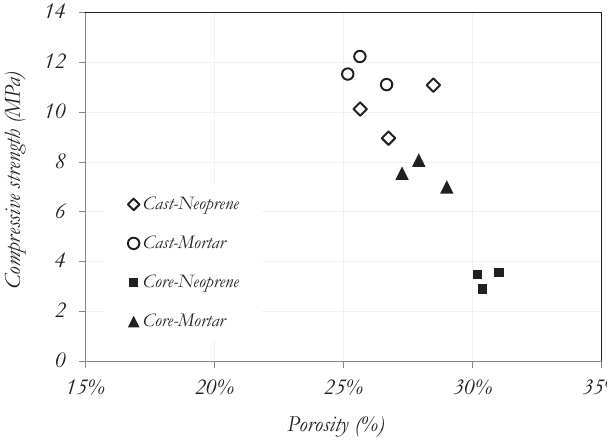
Figure 11 Compressive strength vs. porosity of cast and cored specimens by capping method